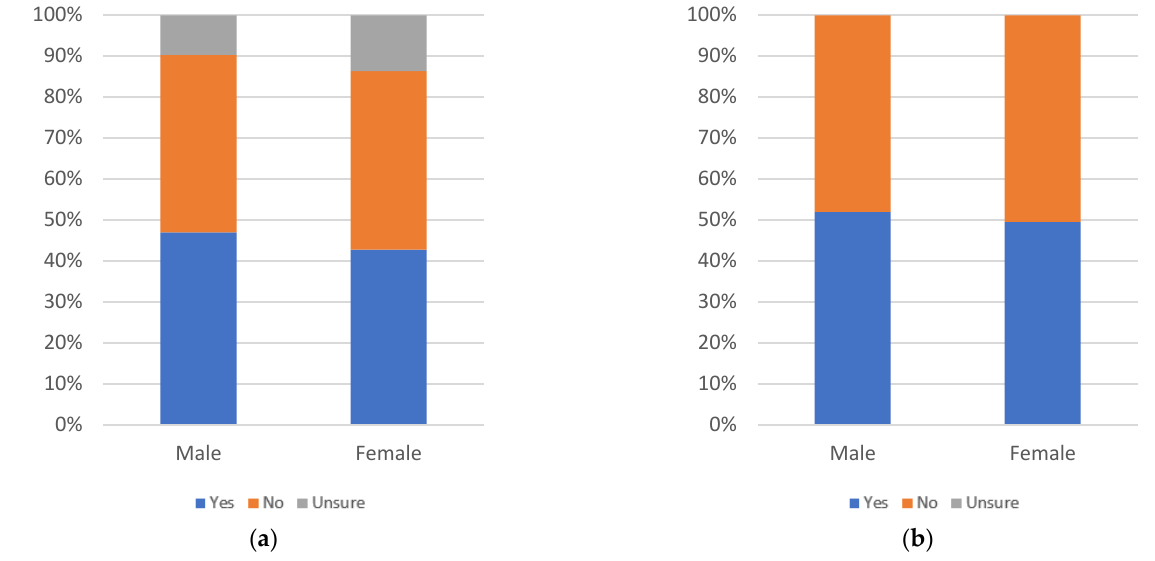
Figure 42. Label annoyingness, by gender: ( a ) with uncertain respondents (left) and ( b ) without uncertain respondents (right).